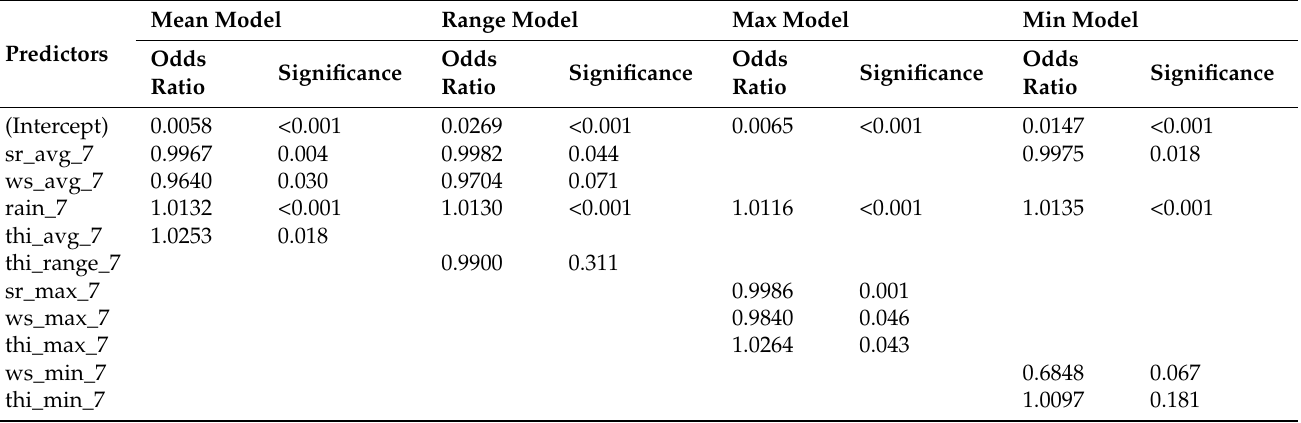
Table 9. The odds ratios for the effect of THI (mean, max, range, and min) plus solar radiation (SR W/m 2 ), wind speed (WS m 2 ), relative humidity (RH g/m 3 ), and rain (mm) on the incidence of pH non-compliance.